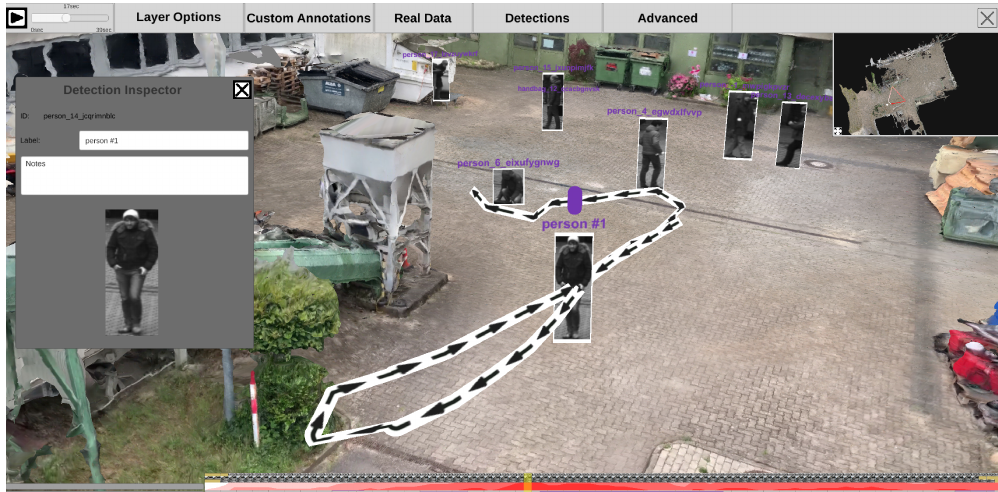
Figure 21. The trajectory of a selected detection is visualized as a directed path within the scene. A menu allows to change the displayed title of a detection and to leave